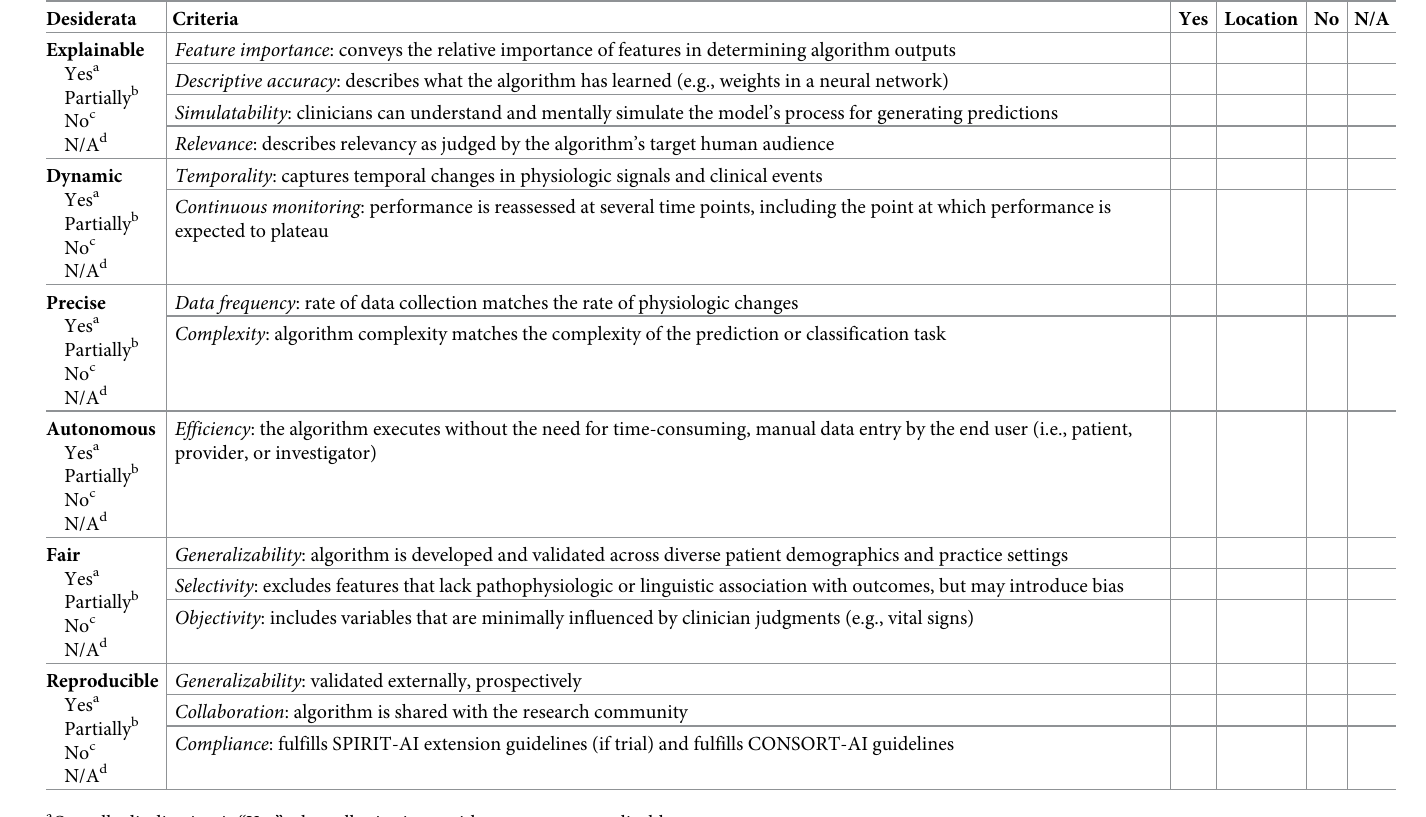
Table 1. Checklist for ideal algorithms in